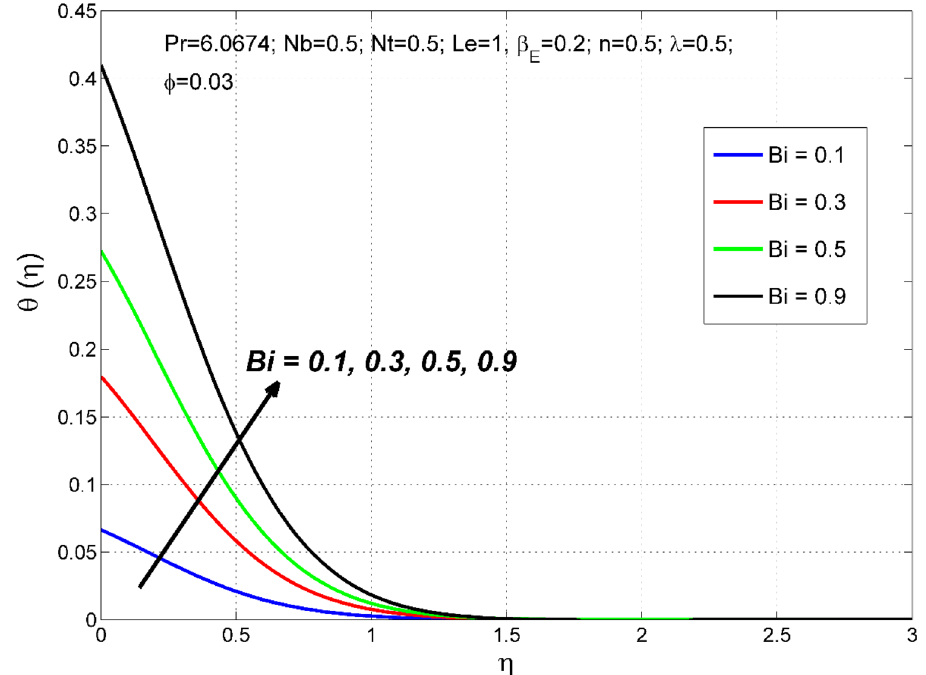
Figure 7. The temperature distribution θ (η) behavior for the variation of the Biot number Bi .